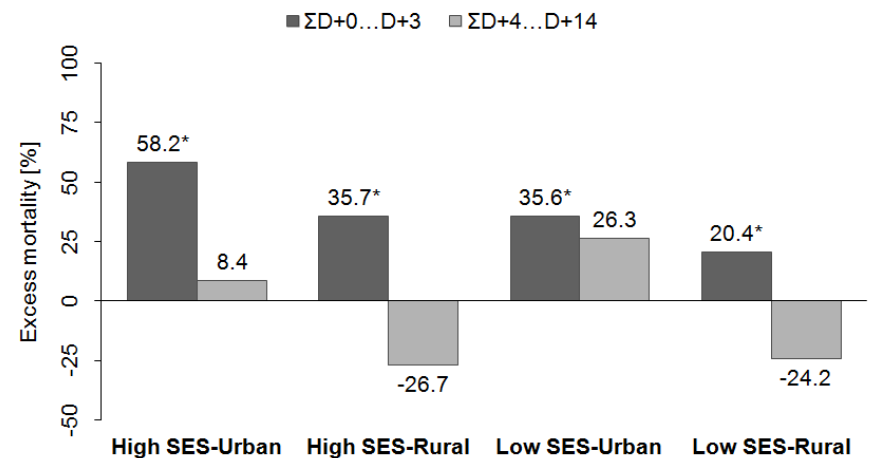
Figure 6. Mean relative excess mortality due to CVDs on days D − 2 to D + 14 around a hot spell’s onset in the groups of districts . Confidence bounds around the zero line are indicated by dashed (90%) and solid (95%) lines, respectively.